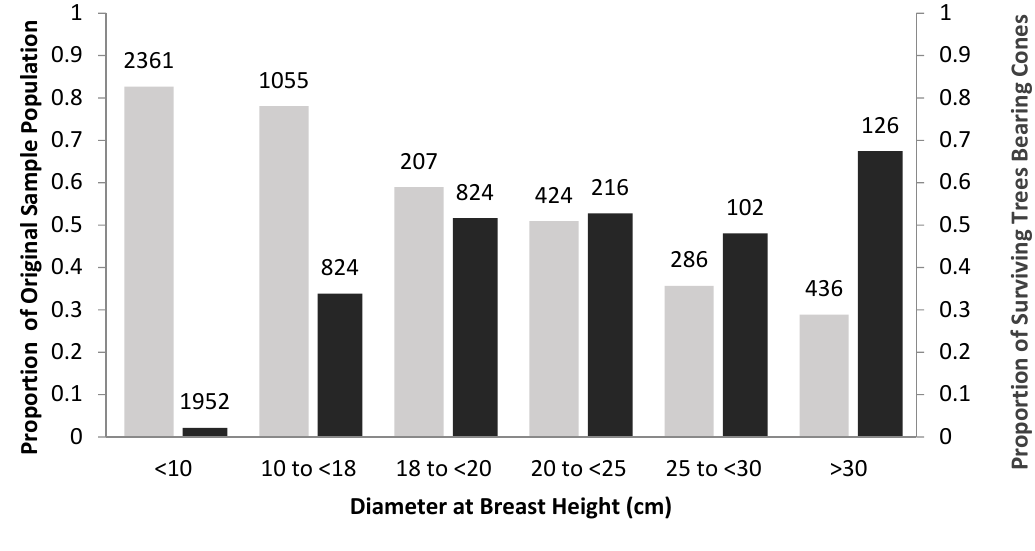
Figure 4. Results for a sample of whitebark pine trees that were living in the 2004–2007 study initiation period and monitored through a 2012–2014 resample period. Rates of tree survival during the study period are shown by the gray bars and the left Y axis. Sample size in each diameter class is displayed above the gray bars. Potential reproduction as indicated by evidence of cone bearing (cones, conelets, or cone scars present) for trees alive at the end of the period is shown by the black bars and the right Y axis. Sample size in each diameter class is shown above the black bars. Data from the Greater Yellowstone Whitebark Pine Monitoring Working Group [106].